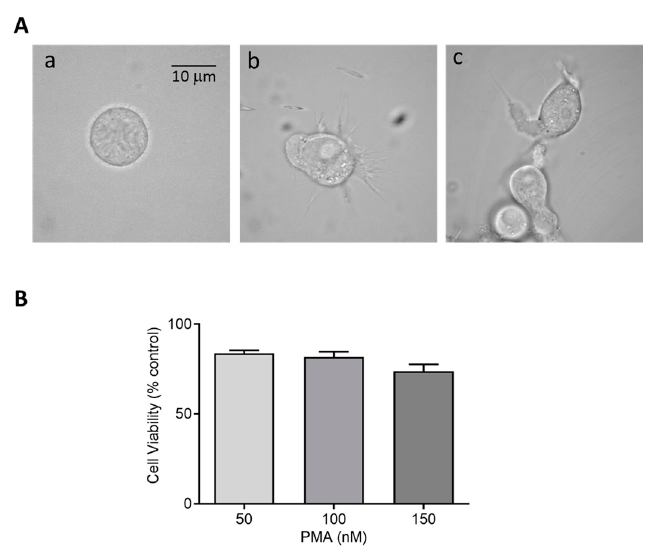
Figure 2. ( A ) Morphology of HL-60 cells in the absence (a) and presence of 50 nM PMA for 48 h (b) and 72 h (c) post incubation at 37 °C. ( B ) Cell viability (%) of HL-60 cells post treatment with 50 nM, 100 nM, and 150 nM PMA. The data are represented as mean ± SE.